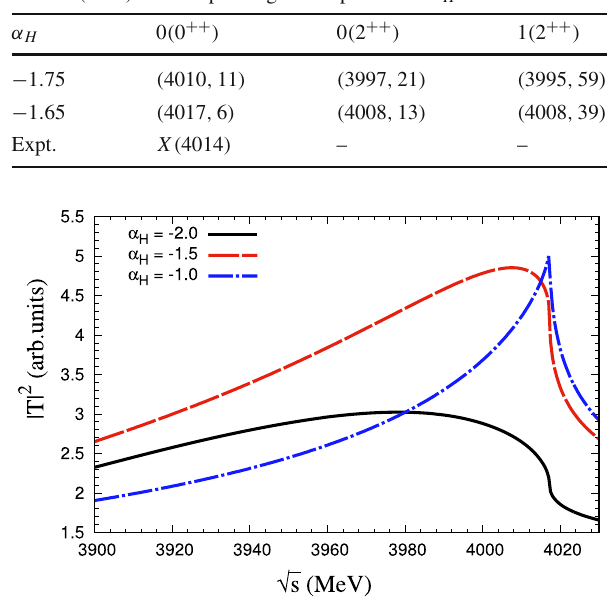
| 2 for the D ∗ ¯ D ∗ → D ∗ ¯ D ∗